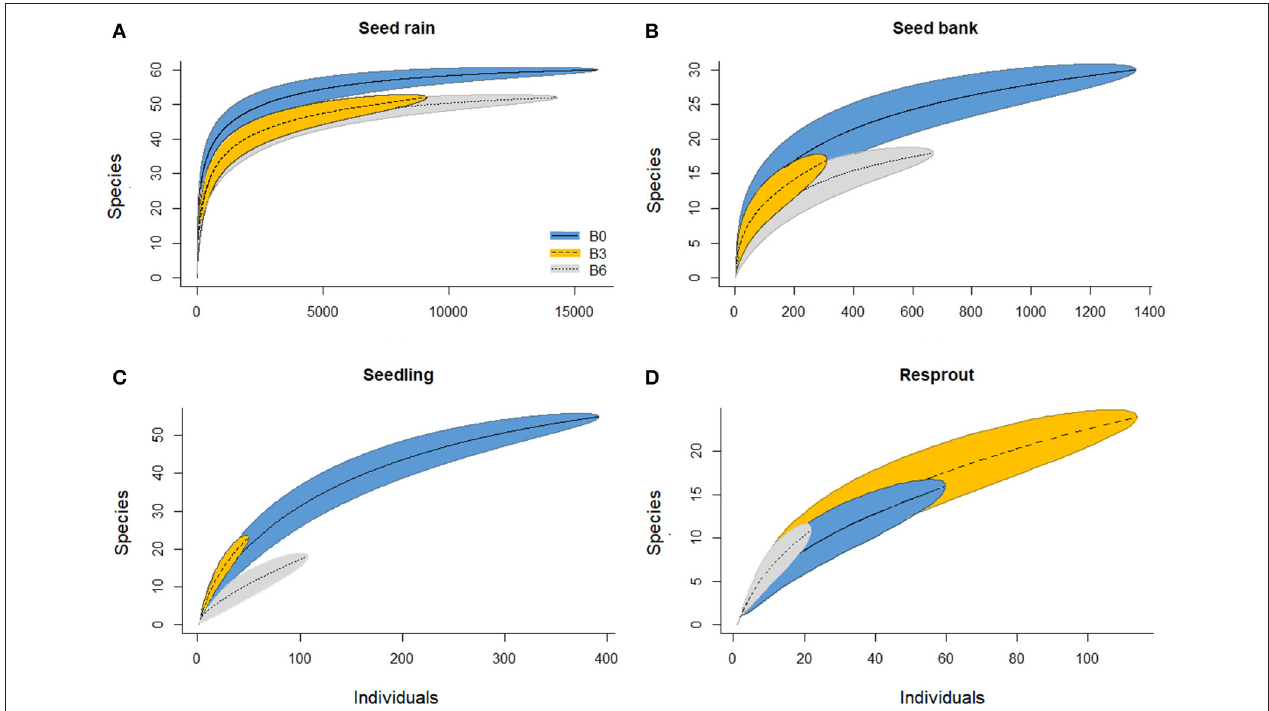
FIGURE 3 | Individual-based species accumulation curves for seed rain (A) , seed bank (B) , seedlings (C) , and resprouts (D) . B0 (control ) was not burned, B3 was burned three times with 3 years interval, and B6 was burned annually, six times. B0 shows 95% confidence interval.